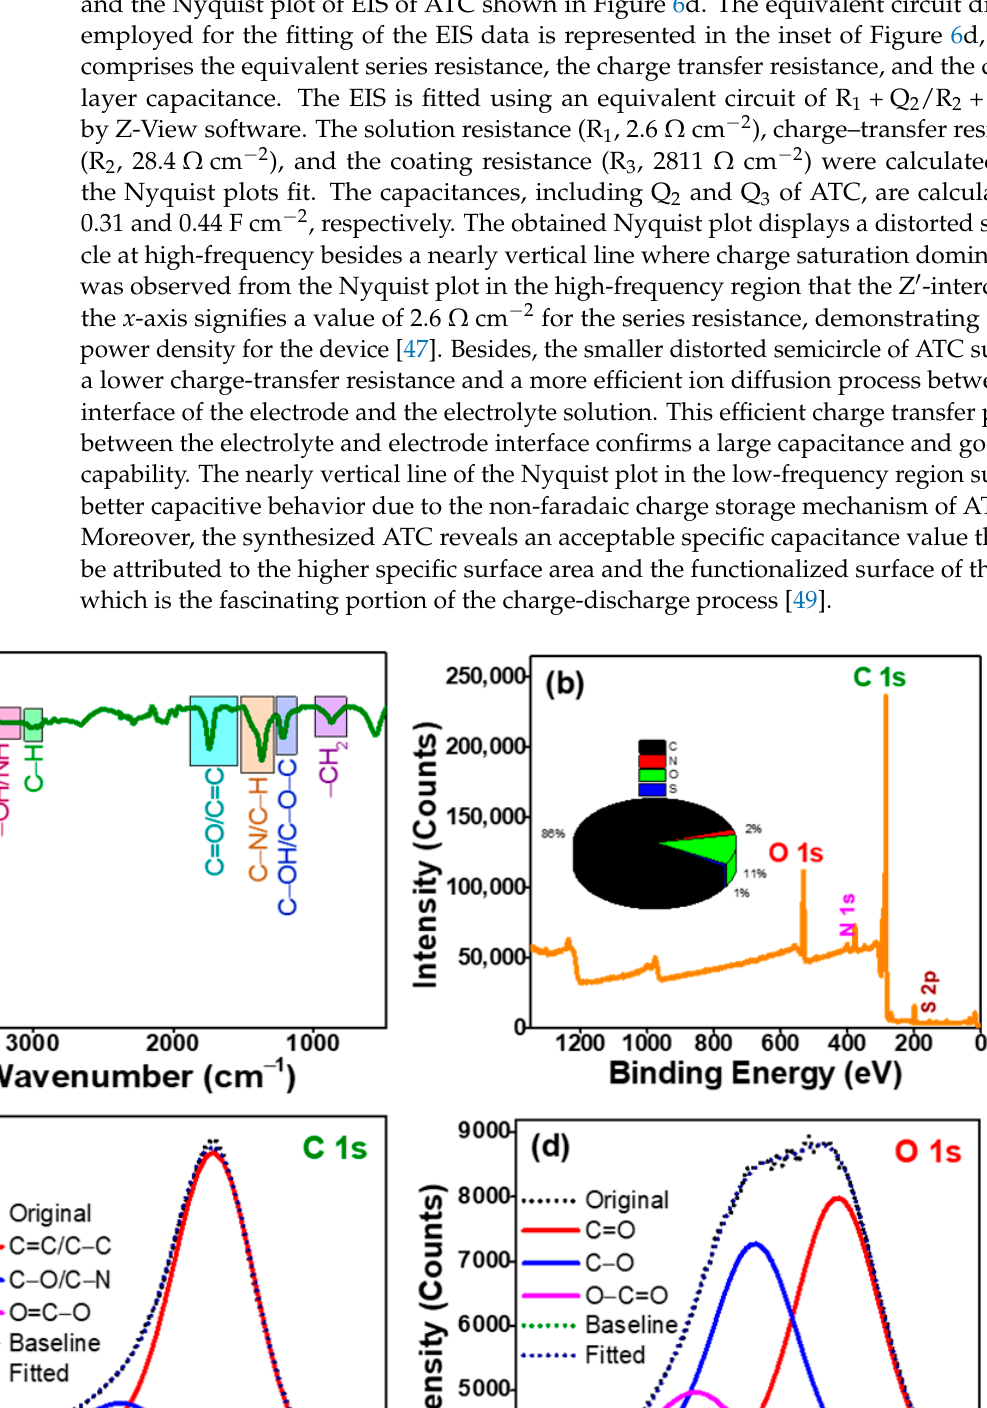
Figure 5. ( a ) ATR-FTIR and ( b ) XPS spectrum of the prepared ATC (inset: elemental composition chat of ATC). High-resolution XPS spectra ( c ) C 1 s, ( d ) O 1 s, ( e ) N 1 s, and ( f ) S 2p of ATC. The cyclic voltammetry (CV) curves at di ff erent scan rates (5 − 100 mV s − 1 ) and gal- vanostatic charge-discharge (GCD) curves at di ff erent current densities (0.5 − 3.0 A g − 1 ) of ATC in a three-electrode system are shown in Figure 6a,b, respectively. The CV curves exhibit stable quasi-rectangular shapes at lower scan rates, representing the ideal EDLC capacitive behavior and good reversibility for the electrolyte ions diffusing rapidly to the electrode interface [44,45]. Besides, the morphology of the CV curve departs to some ex- tent from its quasi-rectangular shapes with increasing scan rates, and the area of the cyclic voltammogram increased with increasing the scan rates, demonstrating the existence of